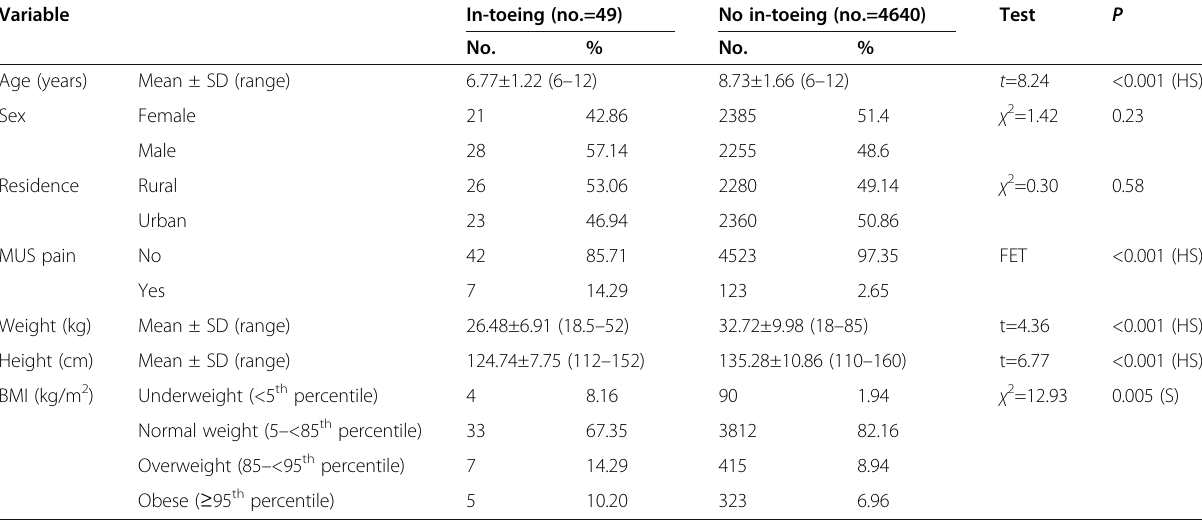
Table 3 Relations between in-toeing, demographic, and clinical findings among the studied children